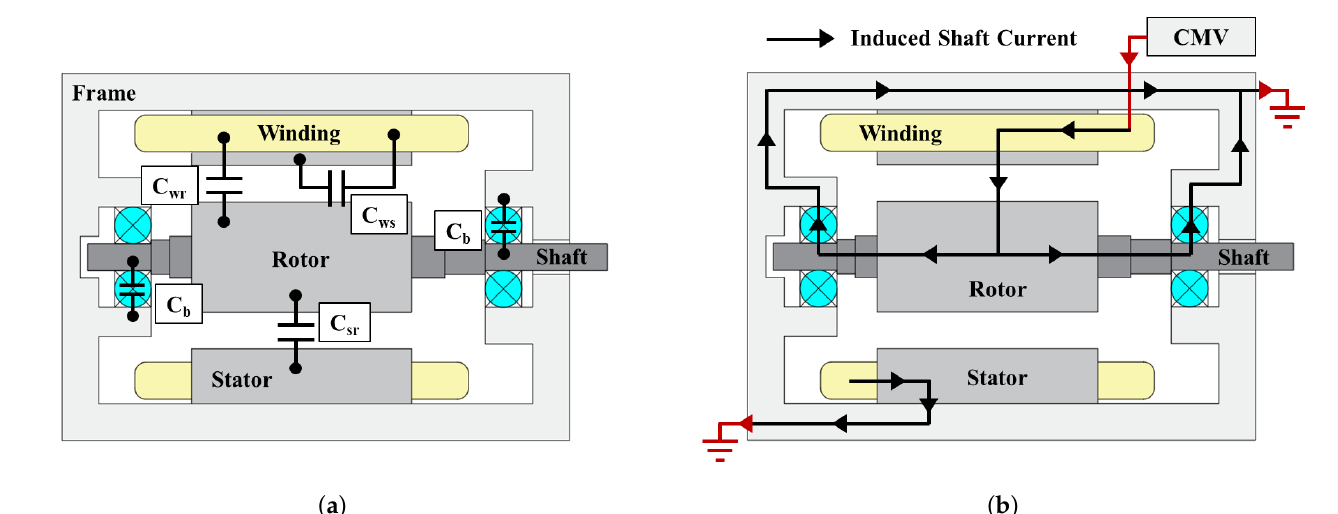
Figure 2. Parasitic capacitance and shaft current. ( a ) Main parasitic capacitances of an electric motor. ( b ) Path of shaft current induced by the common-mode